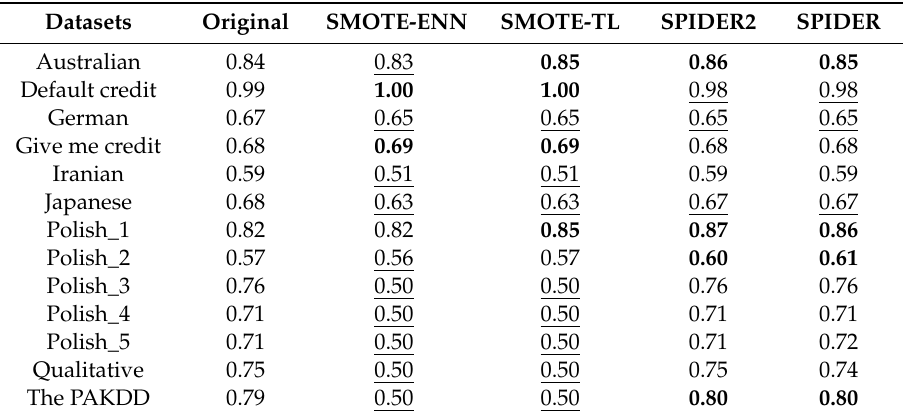
Table 14. AUC for Extended Gamma classifier after hybrid algorithms.